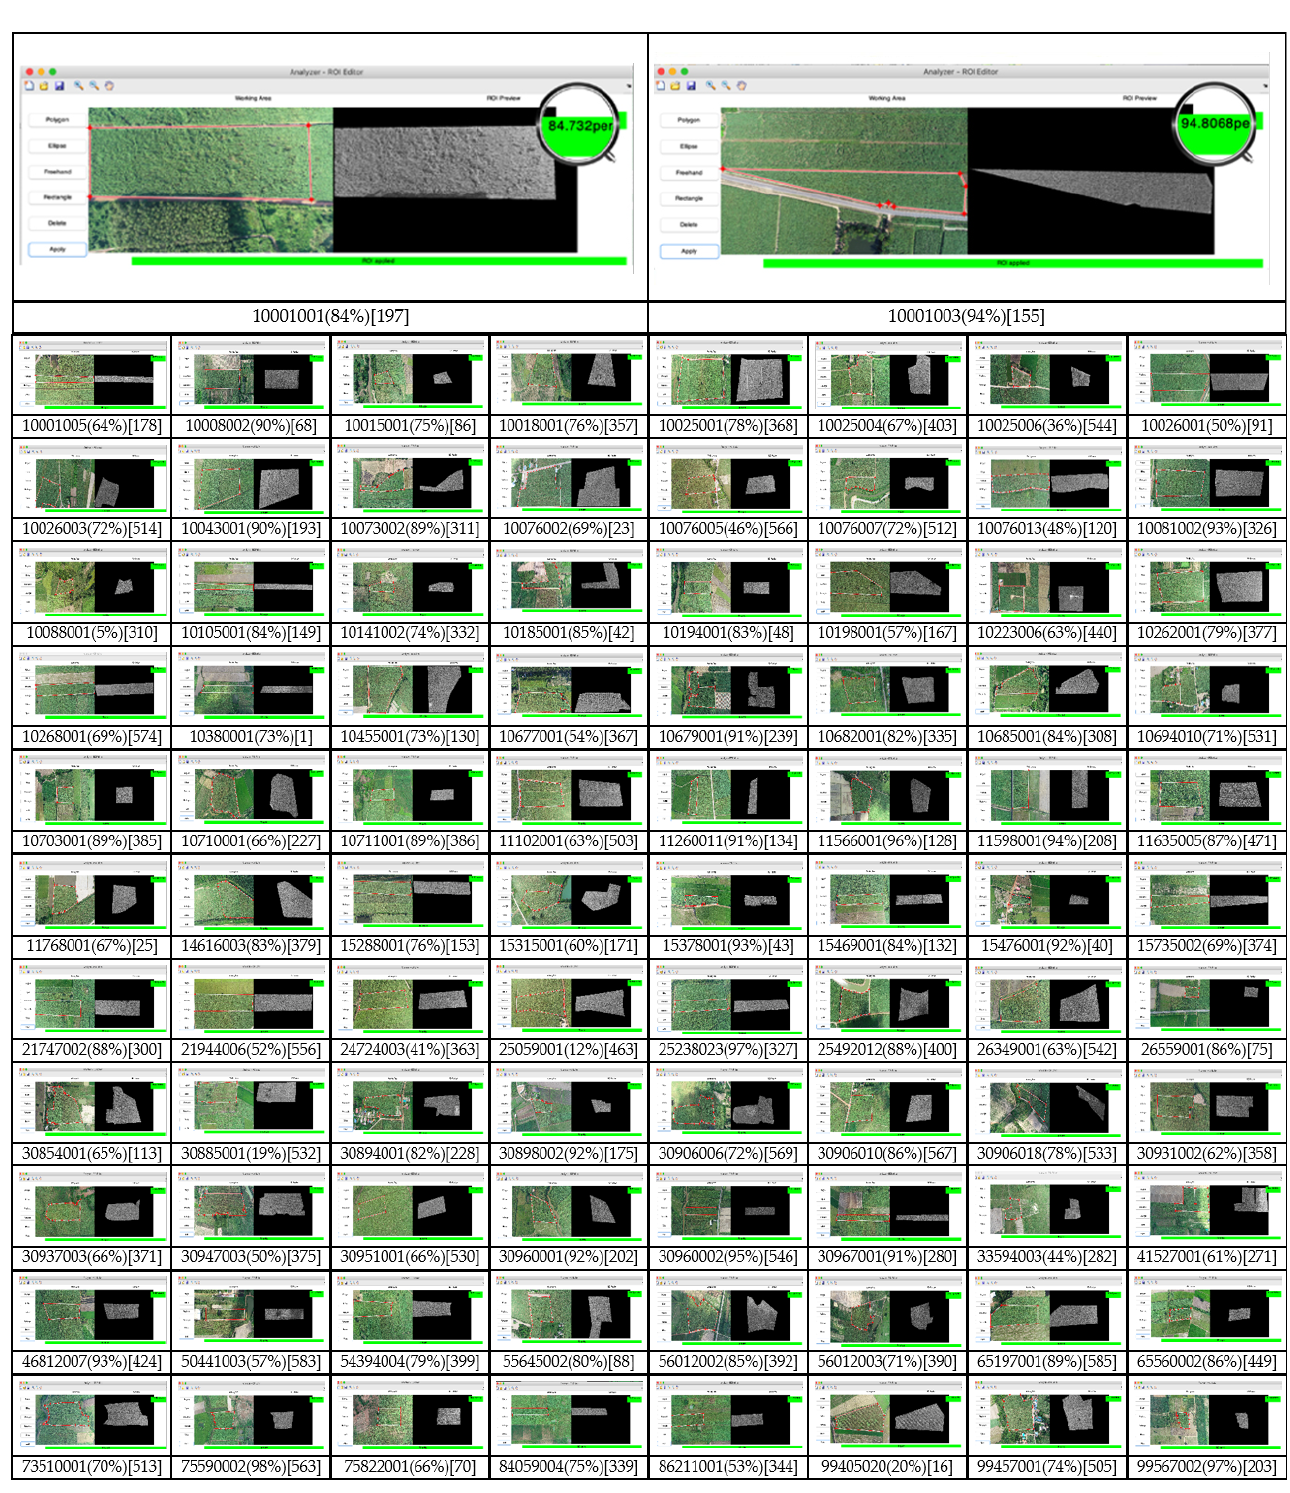
Figure 5. The sugarcane defect detection program’s defect analysis for images in